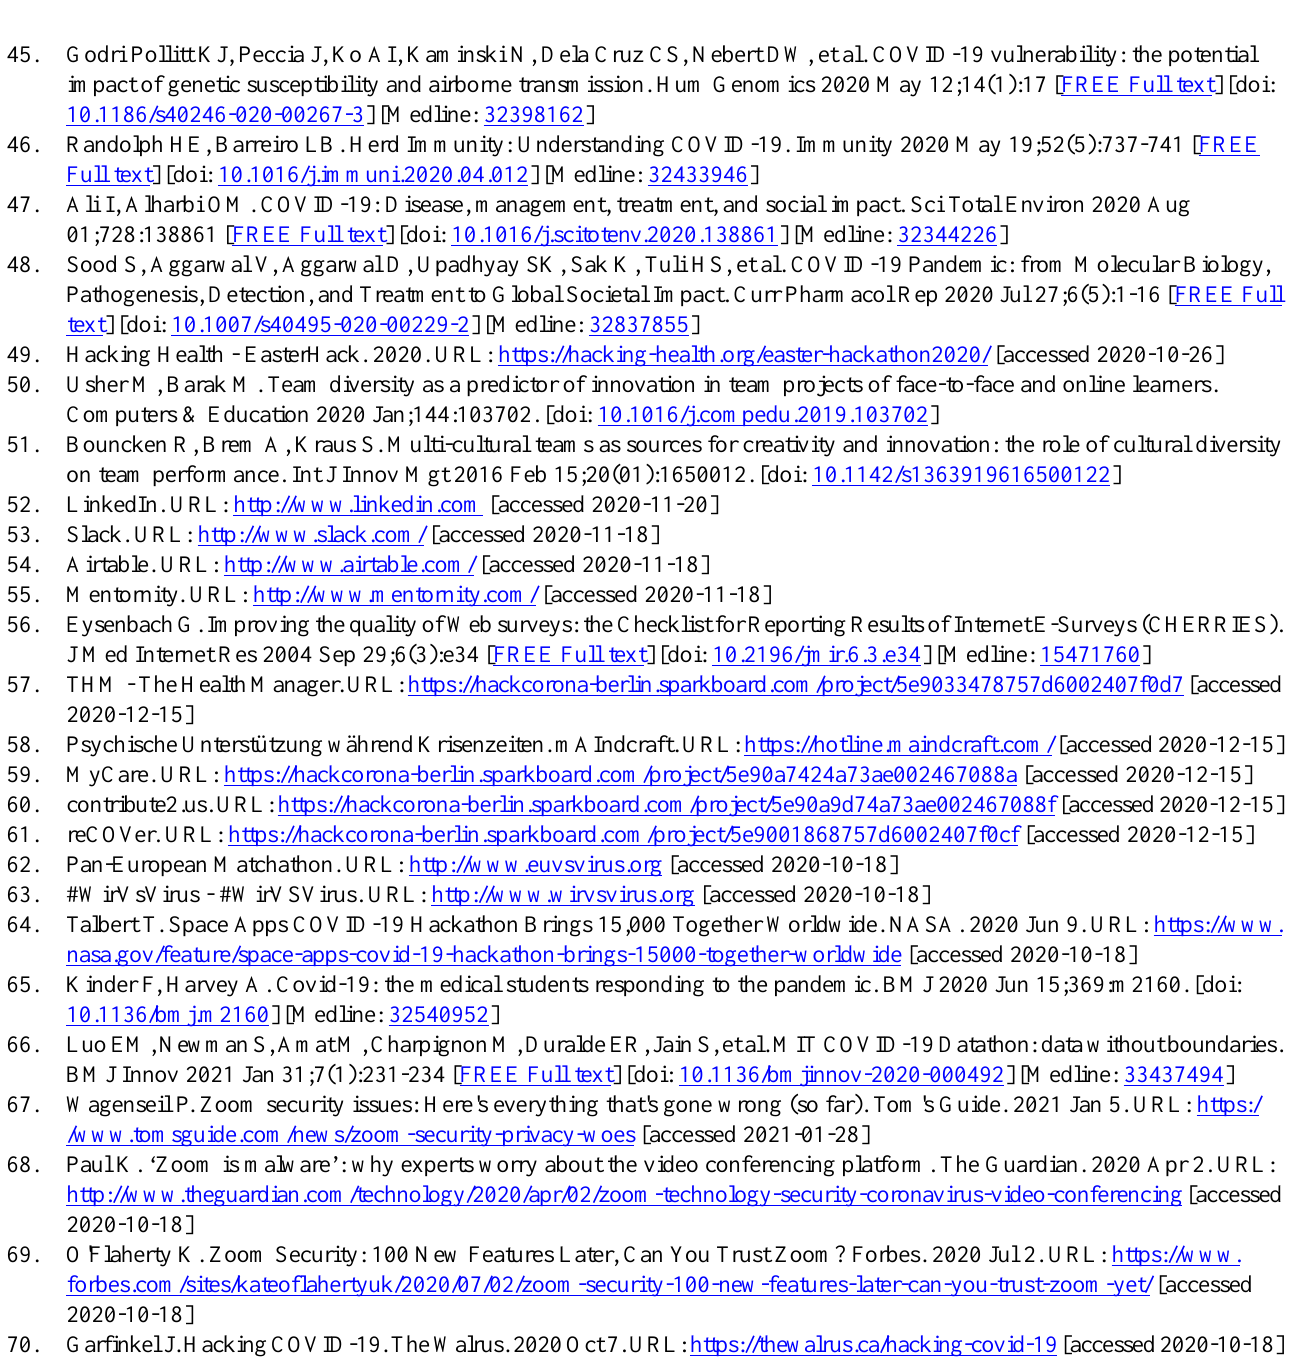
CHERRIES: Checklist for Reporting Results of Internet E-Surveys IT: information